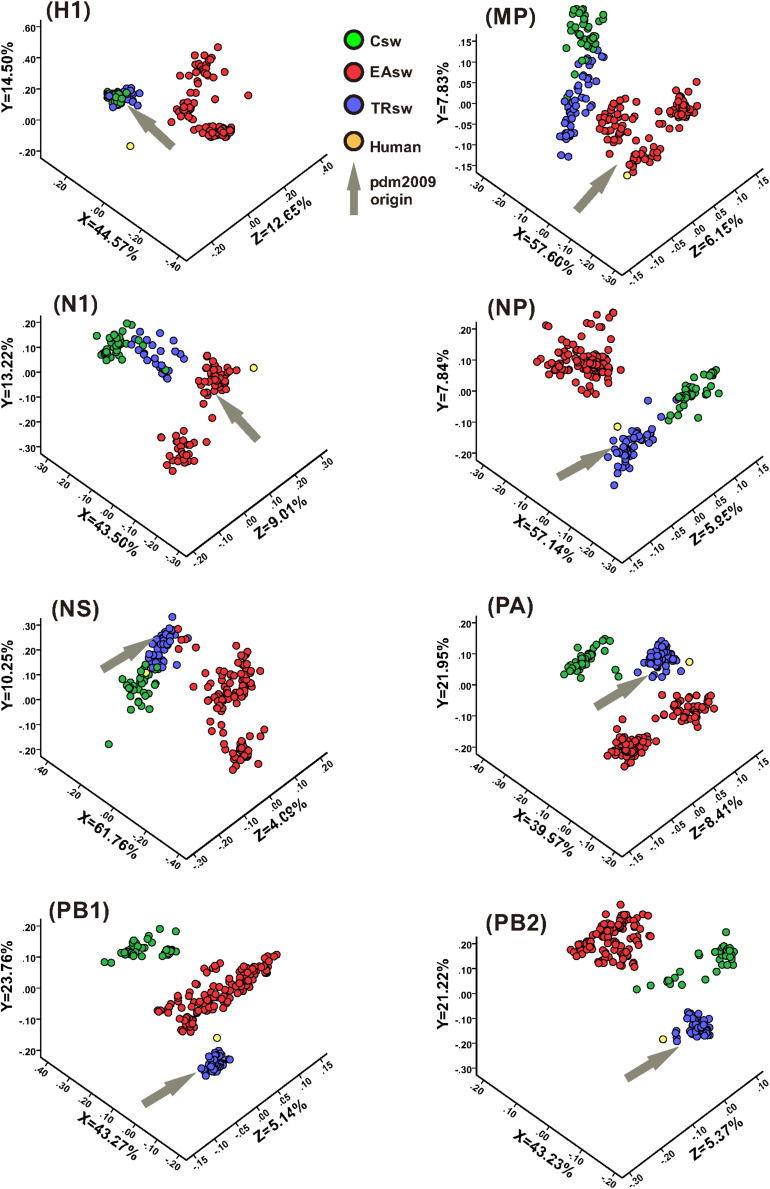
CA analyses of the eight gene segments of various lineages of SIVs. Each viral gene and human sequence are displayed in a three-dimensional representation from a unified perspective. The X, Y, and Z axes are in arbitrary scales generated by the CA and the weight of each codon in these axes varies in the different segments. Csw SIVs, EAsw SIVs, and TRsw SIVs are shown in green, red and blue, respectively. The human sequence is shown in yellow and the arrows marked in gray represent the origin lineage of the special gene segment of H1N1/pdm2009.